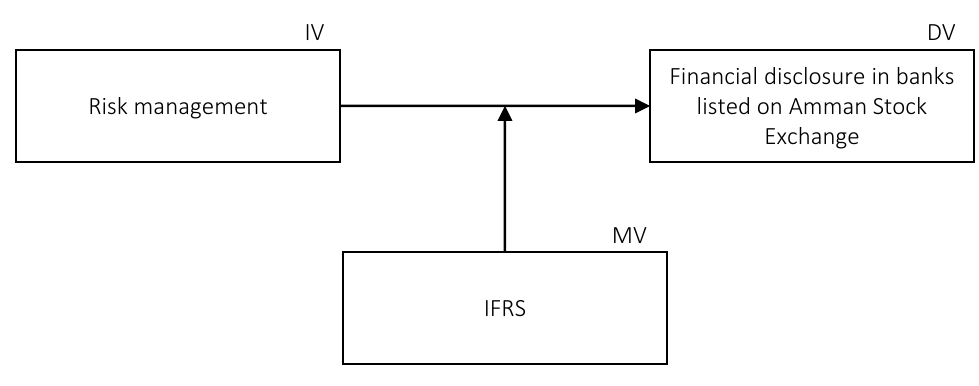
Figure 1. Model of the